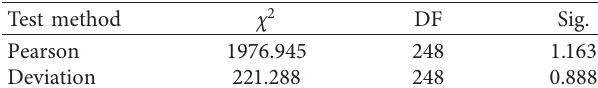
Table 7: Goodness-of-fit